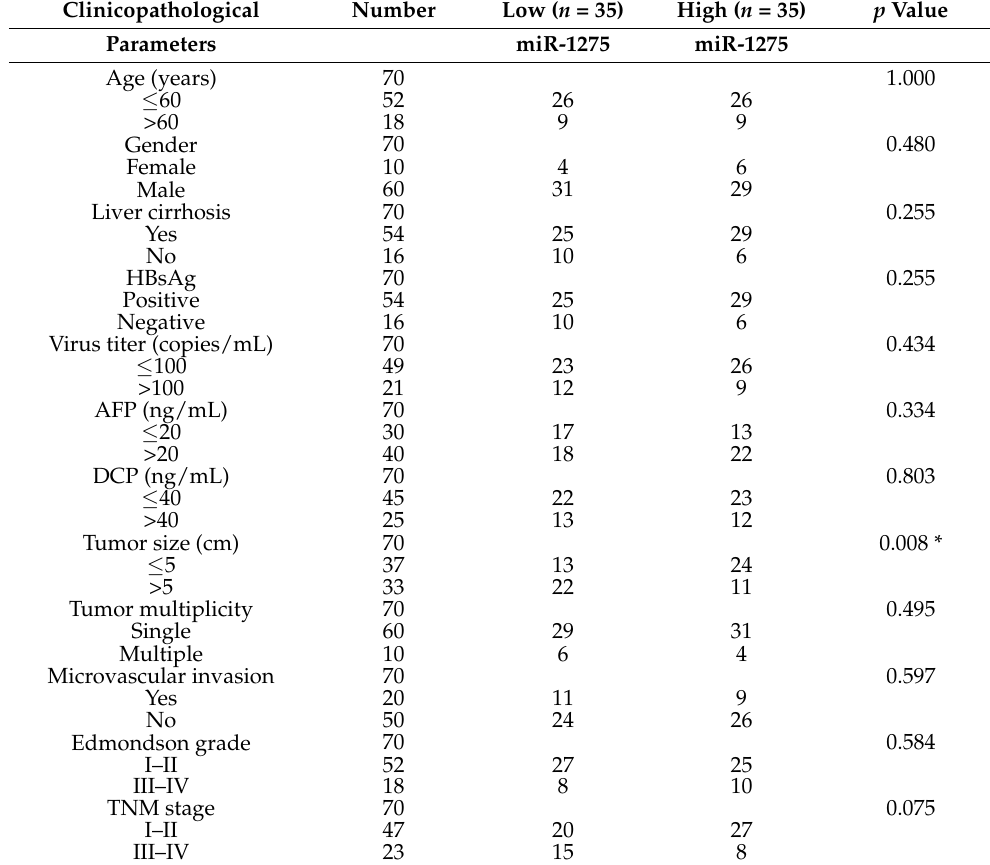
Table 1. Clinical characteristics of HCC patients ( n = 70) grouped according to the expression level of